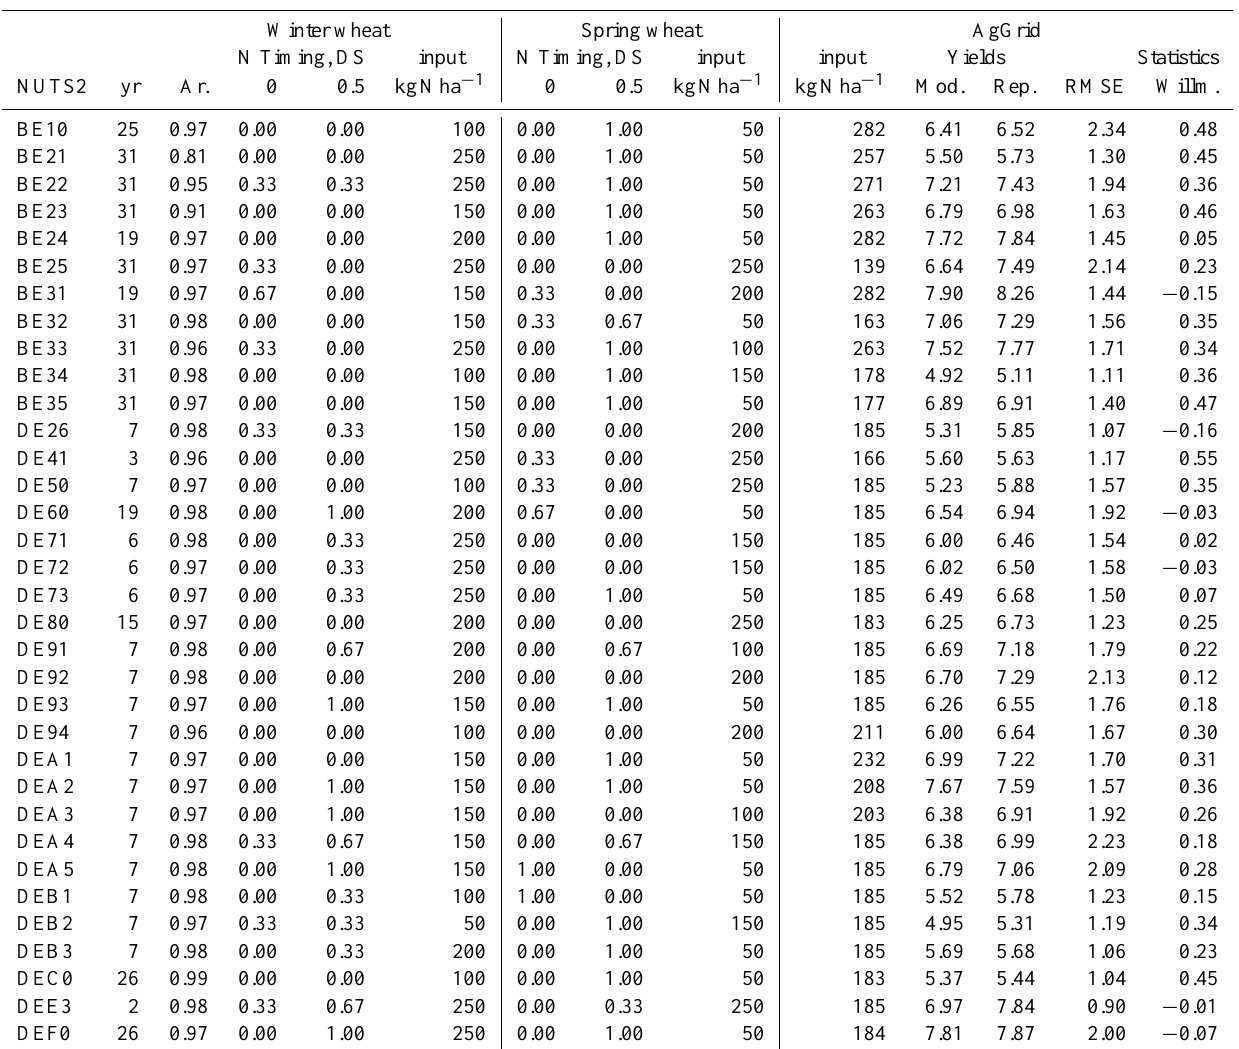
Table A3. Nitrogen fertiliser applications and timing for each NUTS2 (Nomenclature of Territorial Units for Statistics in the EU; statistical administrative areas) region used in the regional simulations resulting from optimising modelled yields against observations ( F opt ( T , A ) ), see Sect. 3.3, together with the statistics (the two last columns). Number of years with reported yields for each region (yr), fraction of the wheat area covered by winter variety (Ar.), fraction with spring variety: 1 – Ar., reported yields and AgGrid N input data for each